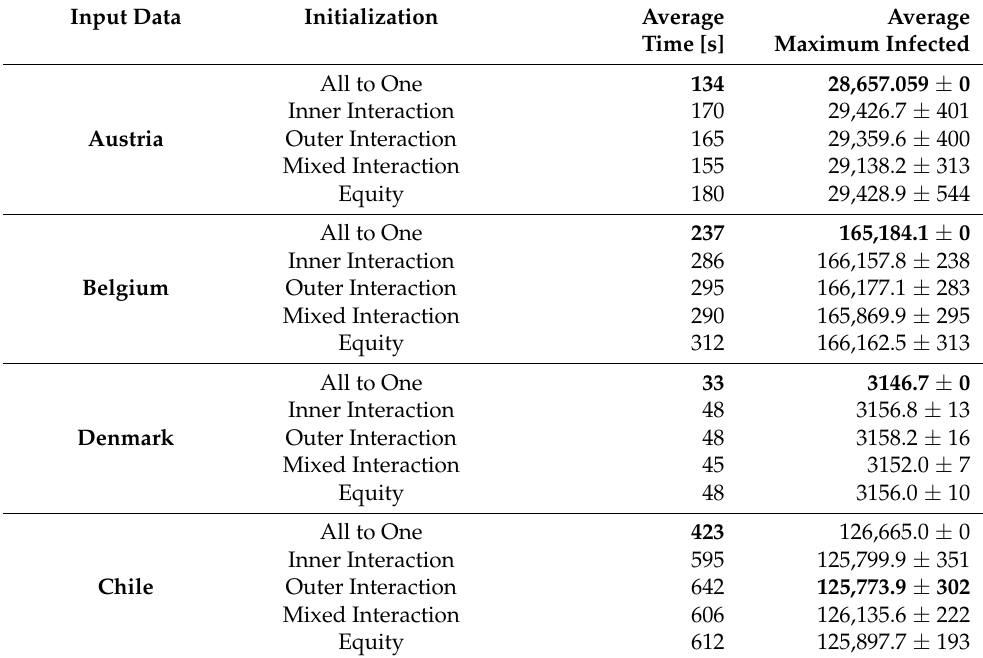
Table 4. Average time and maximum infected population obtained per country file for different initialization procedures. The best value per file is highlighted in